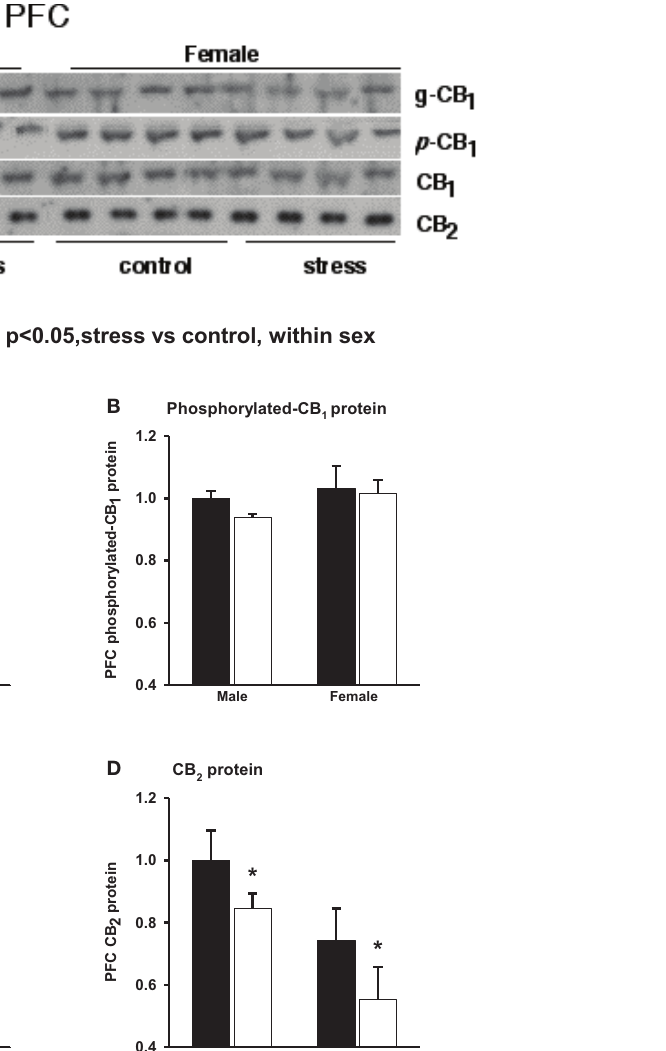
* : p<0.05,stress vs control, within sex